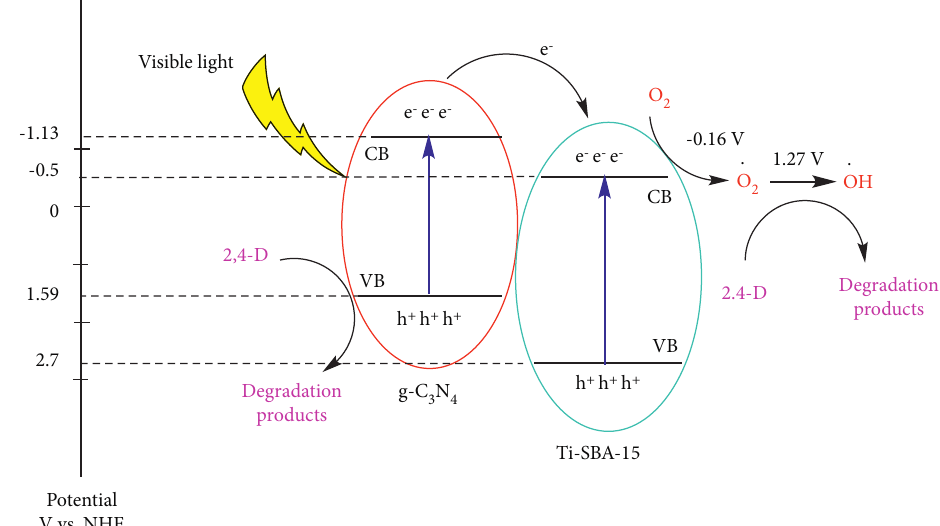
Figure 8: A proposed mechanism diagram of 2,4-D photodegradation on Ti-SBA-15/C